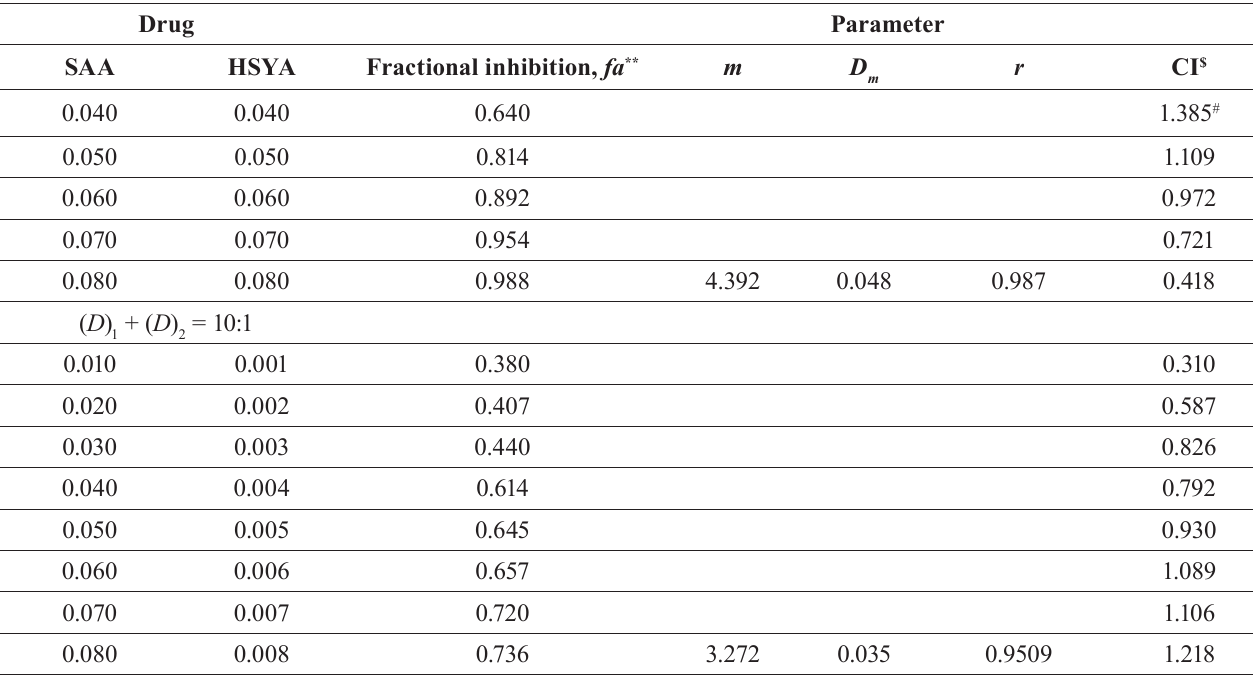
TABLE IV - Example of experimental design and dose-effect relationships of SAA and HSYA, and their two-drug combinations on growth inhibition of rat brain microvascular endothelial cells in vitro * Drug Parameter SAA HSYA Fractional inhibition, fa